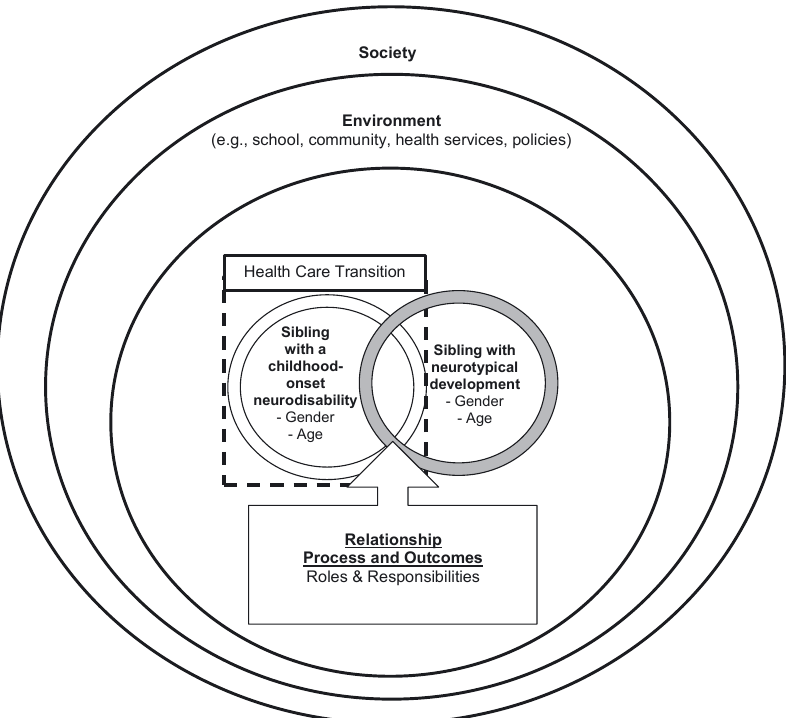
Figure 1: Initial conceptual